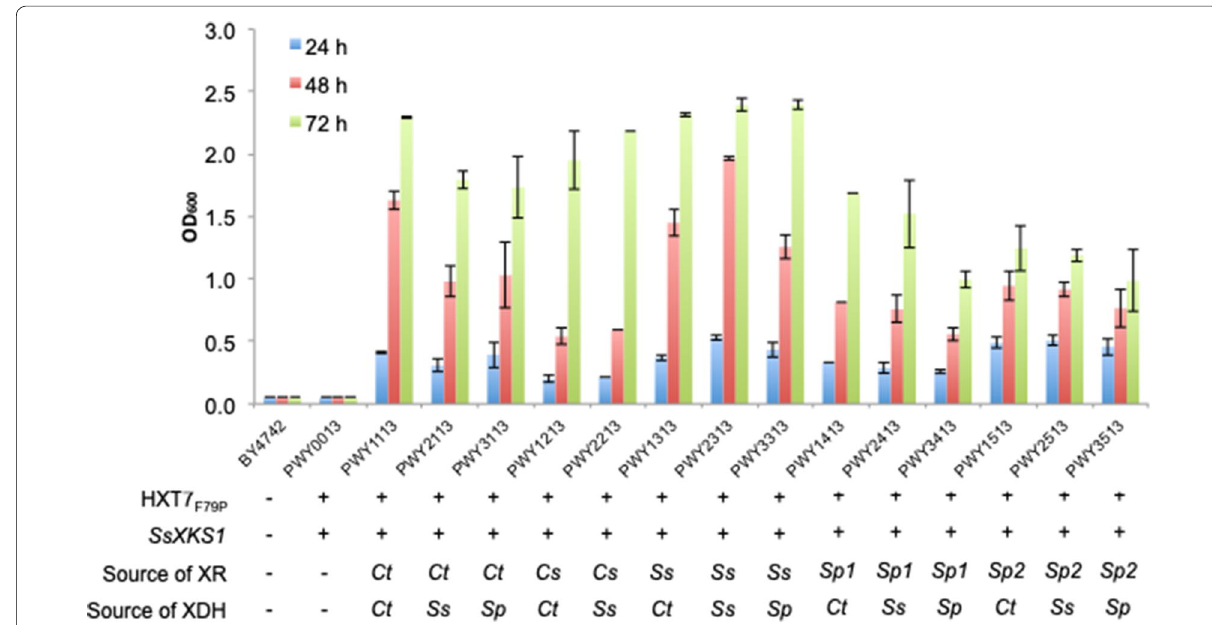
Fig. 2 Growth profile of engineered S. cerevisiae harboring different XR–XDH variants in S. cerevisiae. Engineered strains were pre-cultured in 5-mL aliquots in yeast selective medium (2% glucose) overnight and used to inoculate 10 mL yeast selective medium (2% xylose) to achieve an initial optical density of 0.05 at 600 nm (OD 600 ). The cultures were grown at 30 °C and 250 rpm in an orbital shaking incubator. Samples were taken at 24, 48 and 72 h time points for OD 600 measurement. Values are the mean of three biological replicates tropicalis ; Cs , Candida shehatae ; Ss , Scheffersomyces stipitis ; Sp , Spathaspora passalidarum ; Sp1 , Spathaspora passalidarum XYL1.1 ; Sp2 , Spathaspora passalidarum